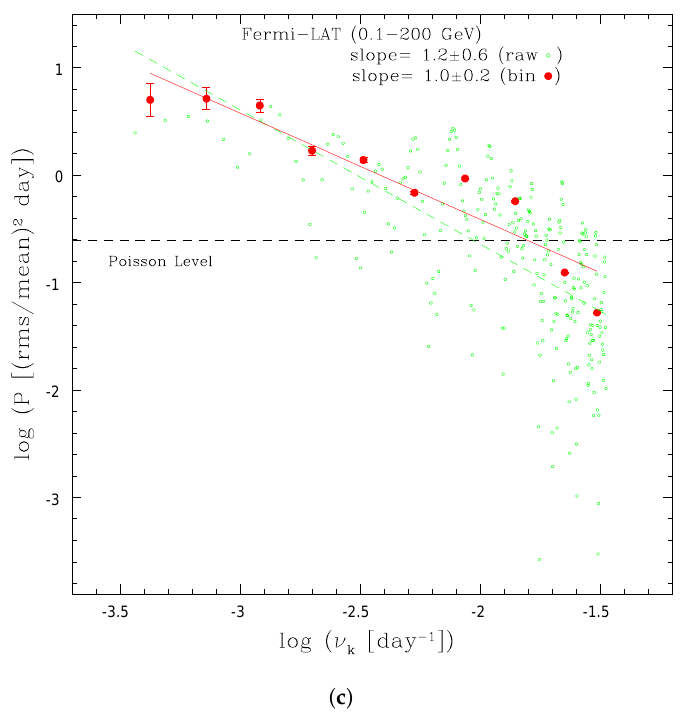
Figure 1. ( a , b ) Power spectral densities (PSDs) corresponding to GHz band radio lightcurves of PKS 0735 + 178 obtained from the Owens Valley Radio Observatory (OVRO) (total time span of ∼ 7years and typical 3 days sampling) and the University of Michigan Radio Astronomy Observatory (UMRAO) (total time span of ∼ 33 years and typical 15 days sampling) monitoring programmes; ( c ) The PSD corresponding to the γ -ray ( Fermi -LAT) lightcurve of the source shown in Figure 3a, covering a time span of ∼ 7 years with 15-day bins. In all panels, empty and filled symbols denote the raw and binned periodogram estimates, respectively, while the dashed horizontal line shows the Poisson noise level due to measurement uncertainty achieved in these